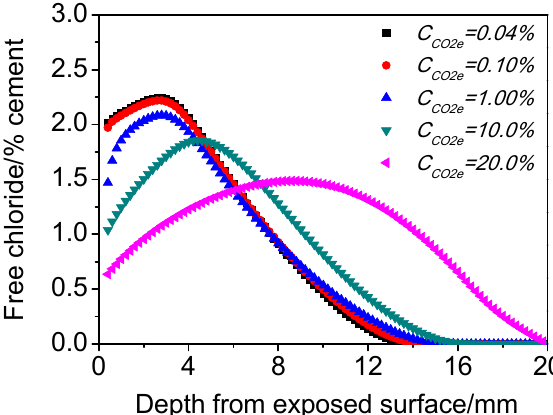
Figure 6. Influence of C co2e on the chloride distribution of concrete subjected to cyclic wetting and drying conditions.